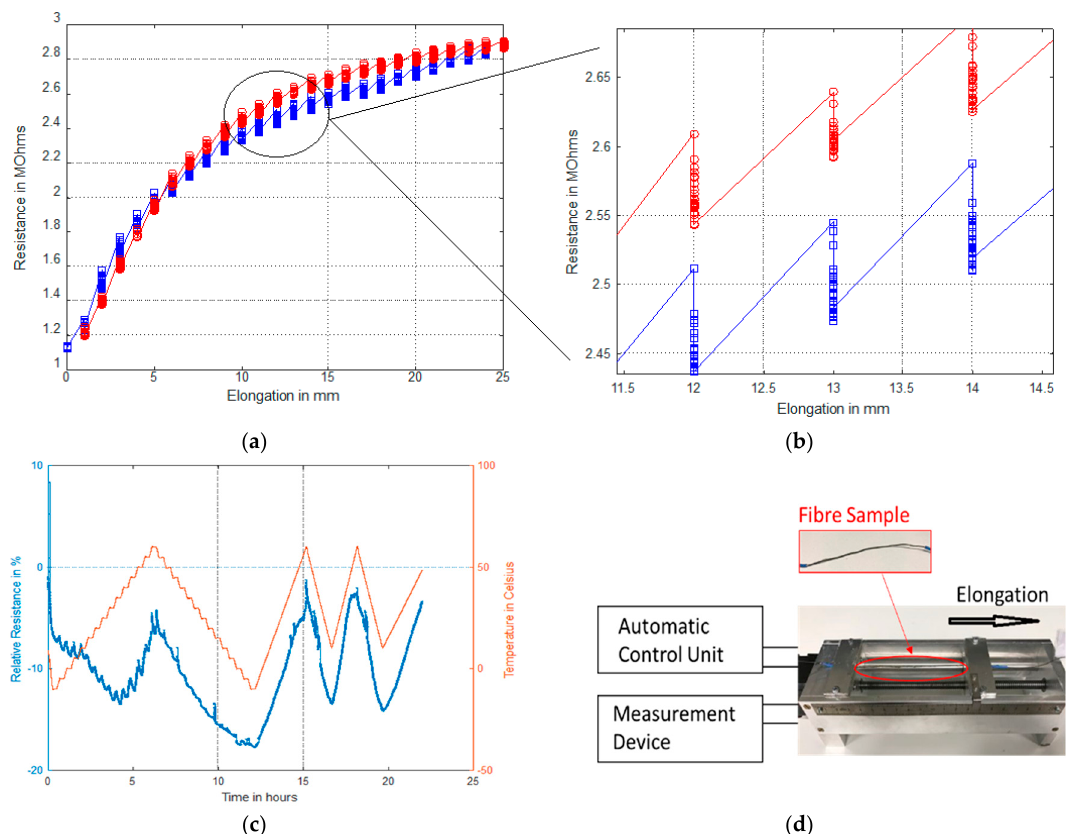
Figure 3. ( a ) Measured resistance values for elongation—load in blue and unload in red; ( b ) Zoomed resistance values at 13mm; ( c ) Relative change of resistance with temperature—relative resistance in blue and temperature in red; ( d ) Test setup for characterization of the sensitive